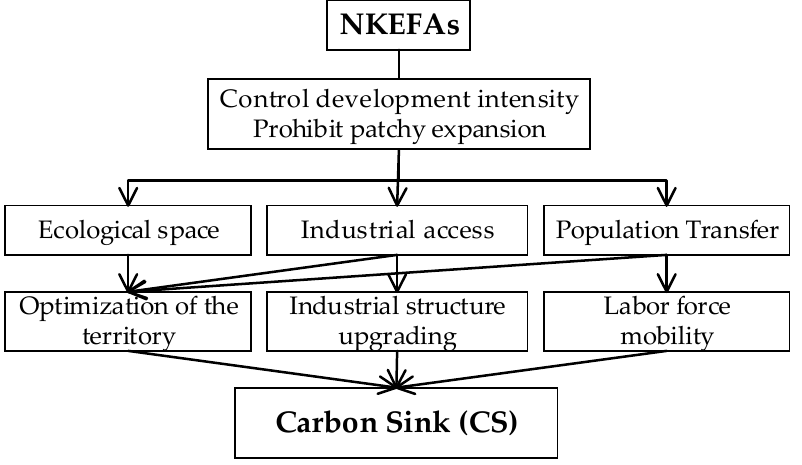
Figure 1. The path of NKEFAs affecting CS. Based on the above literature review and theoretical analysis, this paper focuses on the impact of NKEFAs on CS. Specifically, the NKEFAs is regarded as a “quasi-natural experiment”, and the panel data of 330 cities at the prefecture level and above in China from 2001 to 2019 are used as research samples. A time-varying difference in difference (DID) model is used to assess the impact of NKEFAs on CS. In addition, the event-study approach (ESA) is used to examined the parallel trend and dynamic effects of this policy, and we conduct a series of robustness tests such as placebo test, excluding the influence of other policies. The heterogeneity impact of this ecological policy in terms of functional area type, geospatial distribution, and different quantile levels is further discussed.